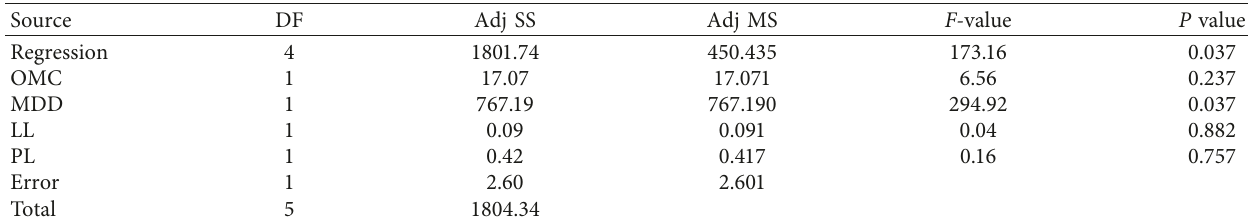
Table 11: Analysis of variance.